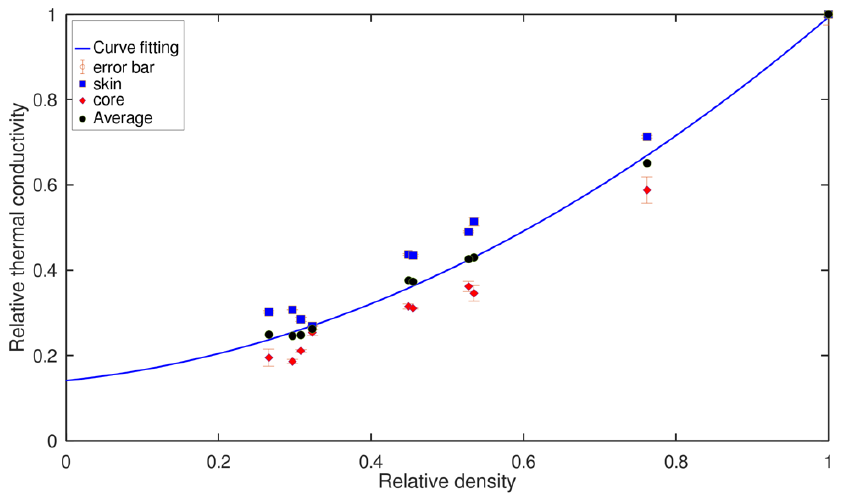
Figure 10. Relative thermal conductivity of the foams under study as a function of the relative density. The curve fit is Equation (6), where ξ 1 = 0.99 ± 0.05 is the contribution of the polymer and ξ 2 = 0.15 ± 0.08 is the contribution of the gas phase, the power is n = 1.6 ± 2 and the R 2 = 0.9016.